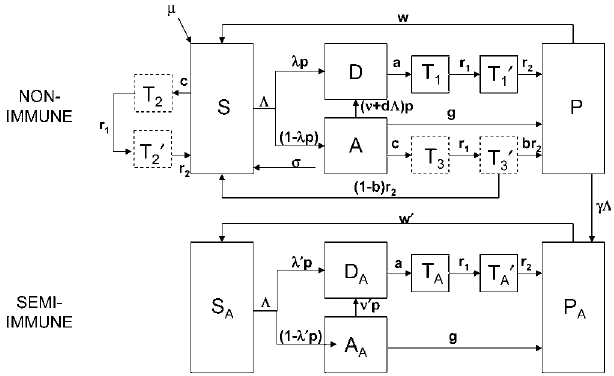
Figure 2. Schematic Diagram of Model of Malaria Illness and Treatment Drug use patterns in symptomatic, asymptomatic, and disease-free individuals. DOI: